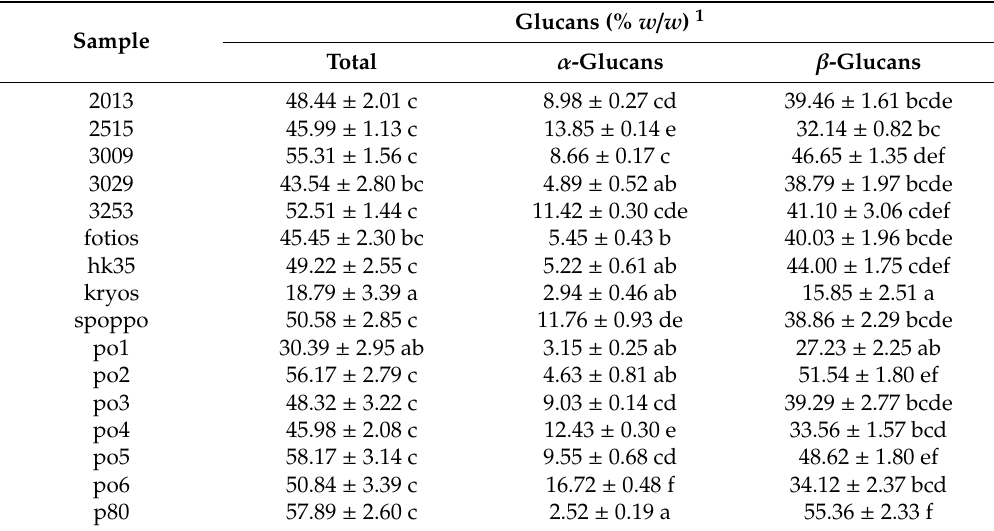
Table 4. Composition of basidiocarps: total, α - and β -glucans (mean ± SD).